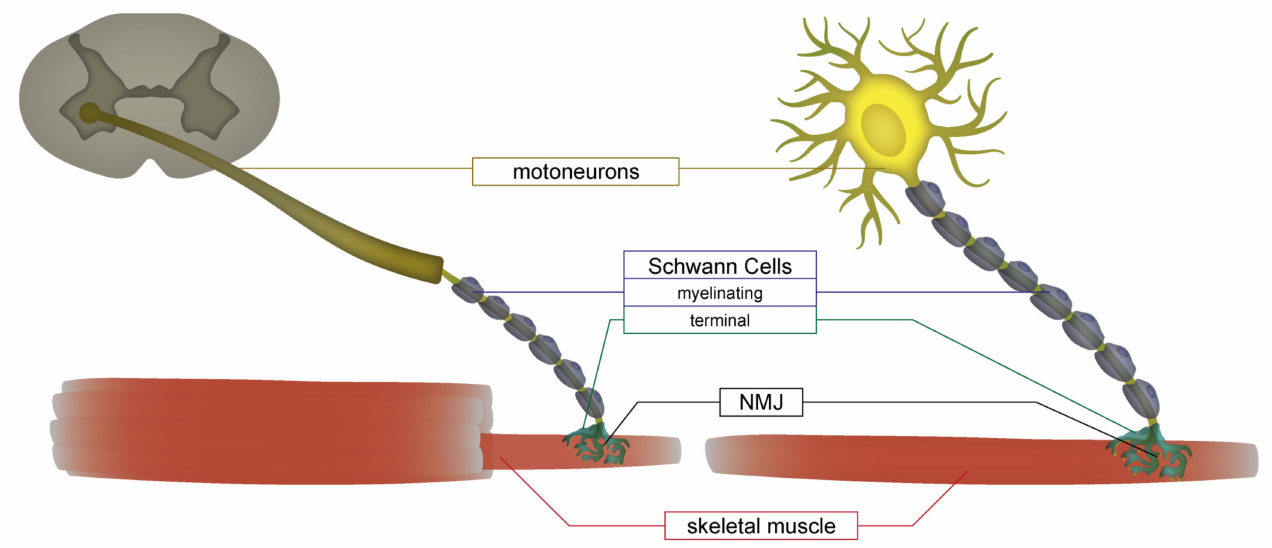
Figure 1. Scheme of the cell components of the core NMJ. Cell bodies of lower motoneurons are located in the ventral horn of the spinal cord (gray structure in the upper left corner), from which their axons extend through spinal nerves to skeletal muscles. Each muscle fiber is innervated at a single synaptic connection, the neuromuscular junction (NMJ). Terminal Schwann cells form an integral part of these synapses; they are different from myelinating Schwann cells, which wrap the axons of motoneurons. For simplicity, further cell types at the NMJ, such as kranocytes and sympathetic neurons, were left